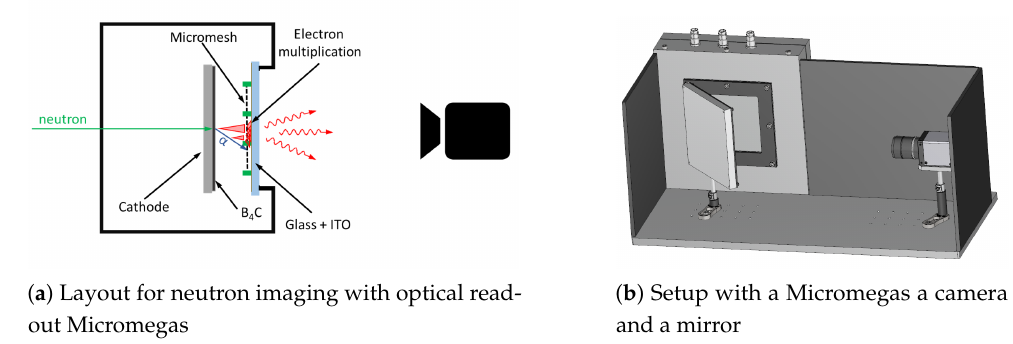
Figure 6. Example of an application of the Micromegas with optical for neutron imaging. The scintillation light emitted during the electron avalanche process can pass thought the glass substrate with the ITO layer and can be collected by a camera ( a ). A mirror can be used in order to avoid exposing the camera to the neutron flux ( b